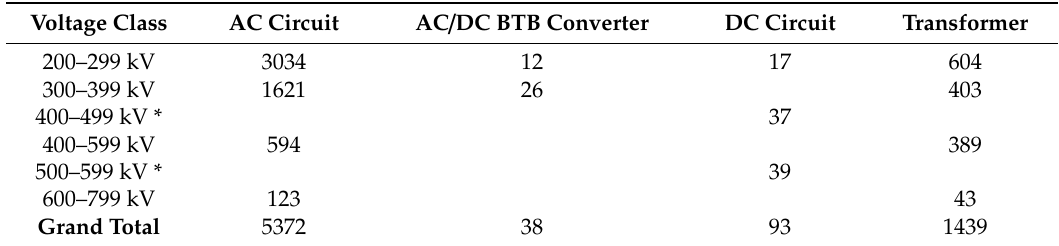
Table 1. Transmission Availability Data System (TADS) automatic outages in clusters by element type and voltage class.